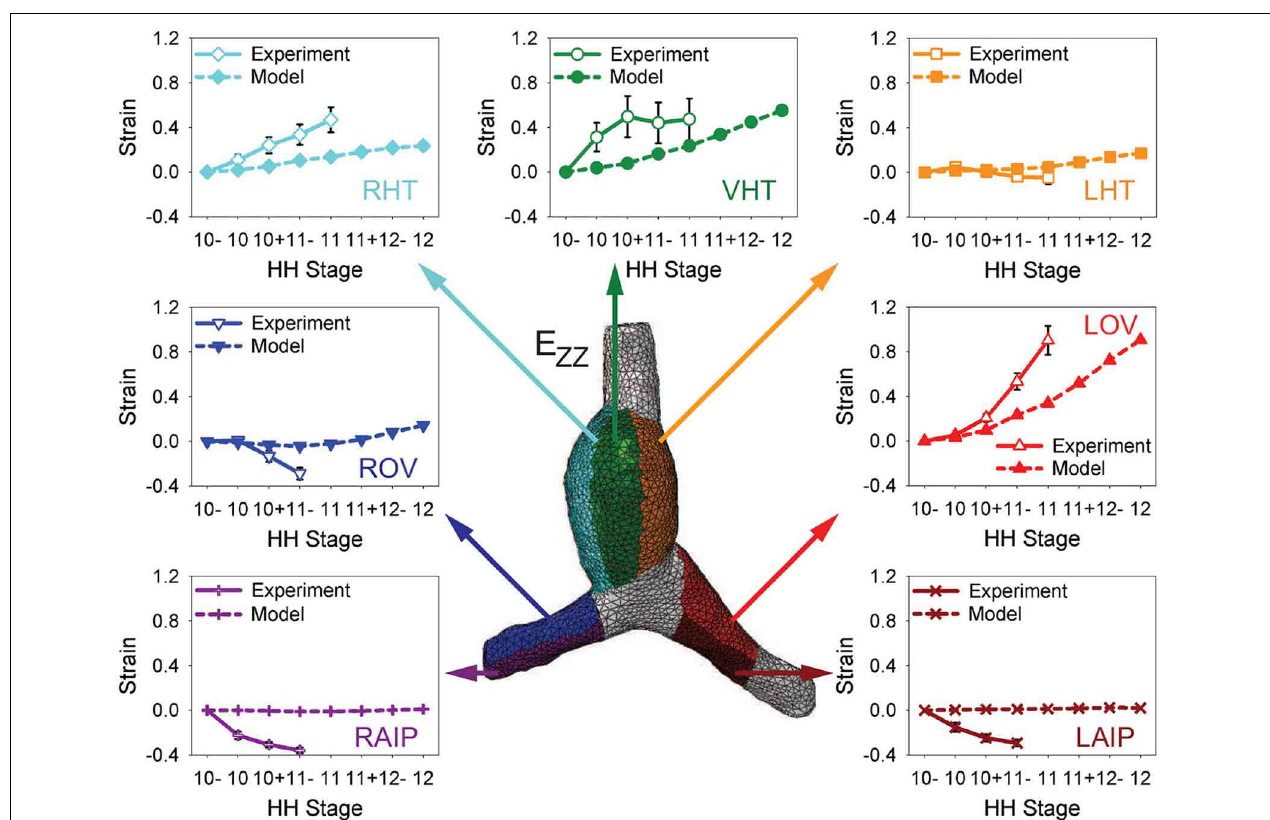
LHT/RHT/VHT, left/right/ventral sides of heart tube; LOV/ROV, cranial half of left/right omphalomesenteric veins; LAIP/RAIP, left/right sides of anterior intestinal